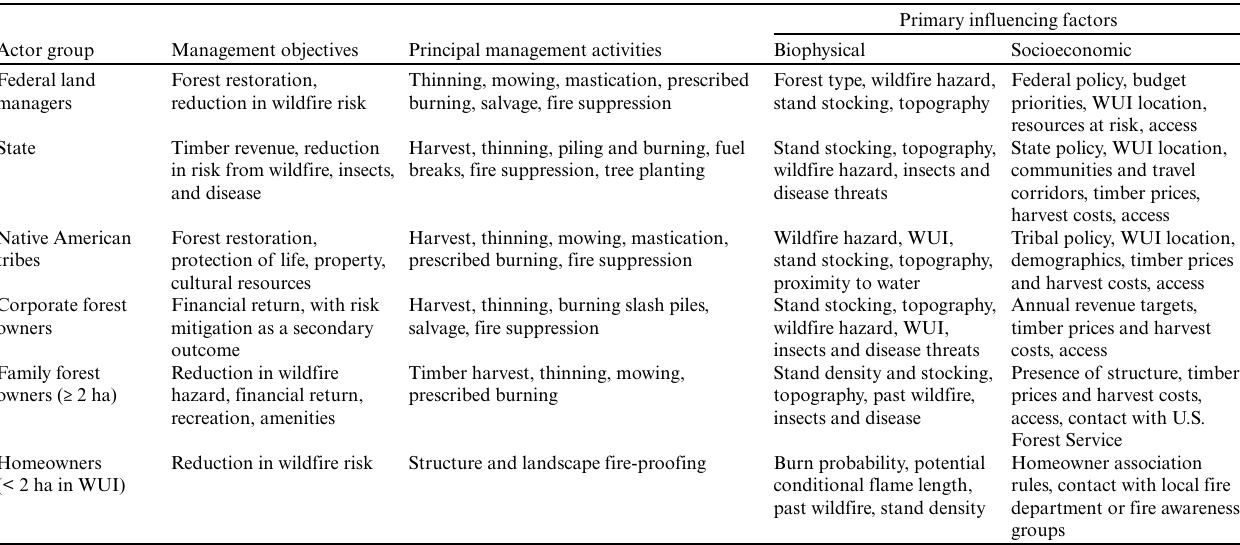
Table 2 . Forest management and wildfire risk mitigation activities of actor groups, and primary influencing factors identified (WUI: wildland–urban